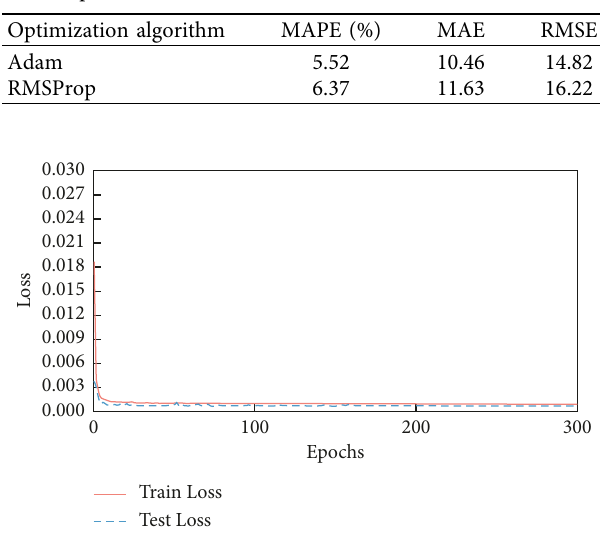
Figure 4: Loss function curves for the training and test sets of multifeature fusion